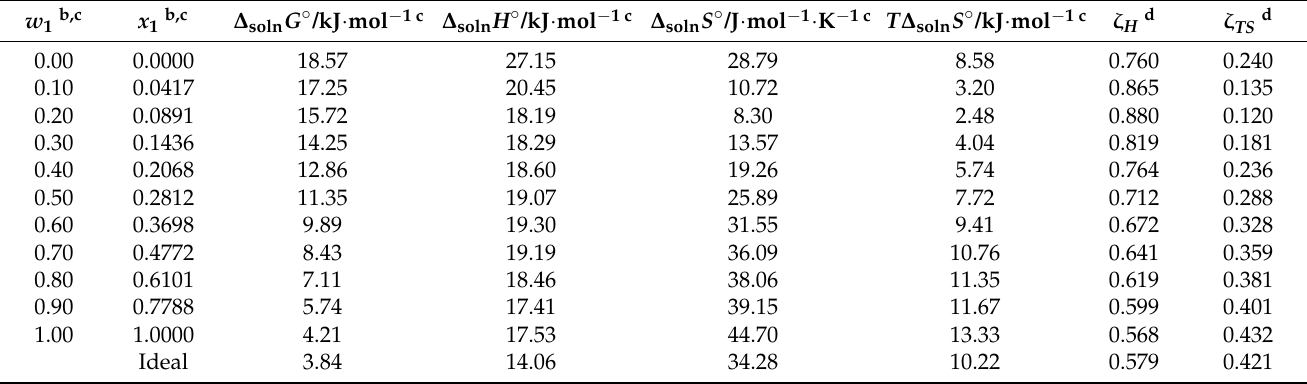
Table 5. Apparent thermodynamic functions relative to dissolution processes of benzoic acid (3) in {ethanol (1) + water (2)} mixtures at T = 298.15 K and p = 90 kPa.